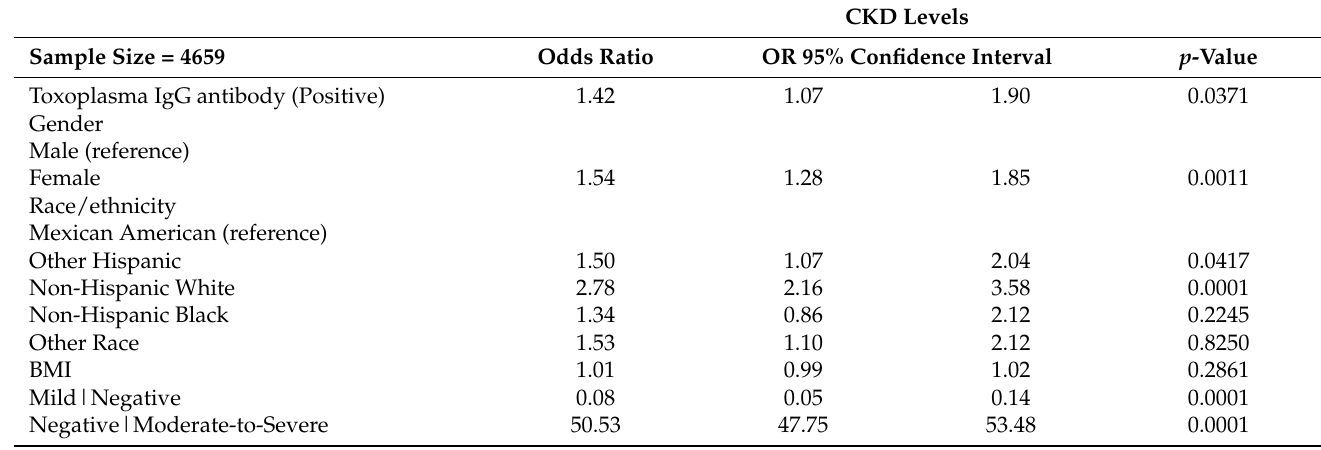
Table 11. Ordinal Logistic regression model for CKD levels on T. gondii IgG antibody (posi- tive/negative) adjusted for the demographic factors (except age) and